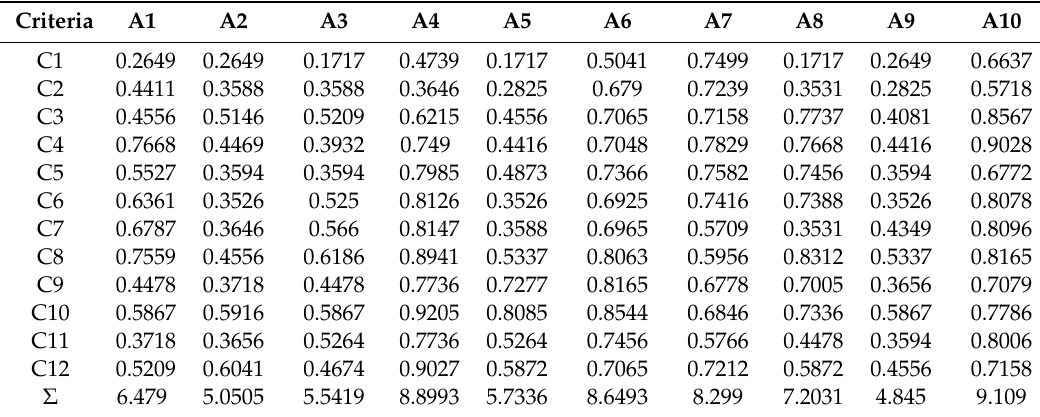
Table 14. Distance d v ( A i , A* ) for alternatives.